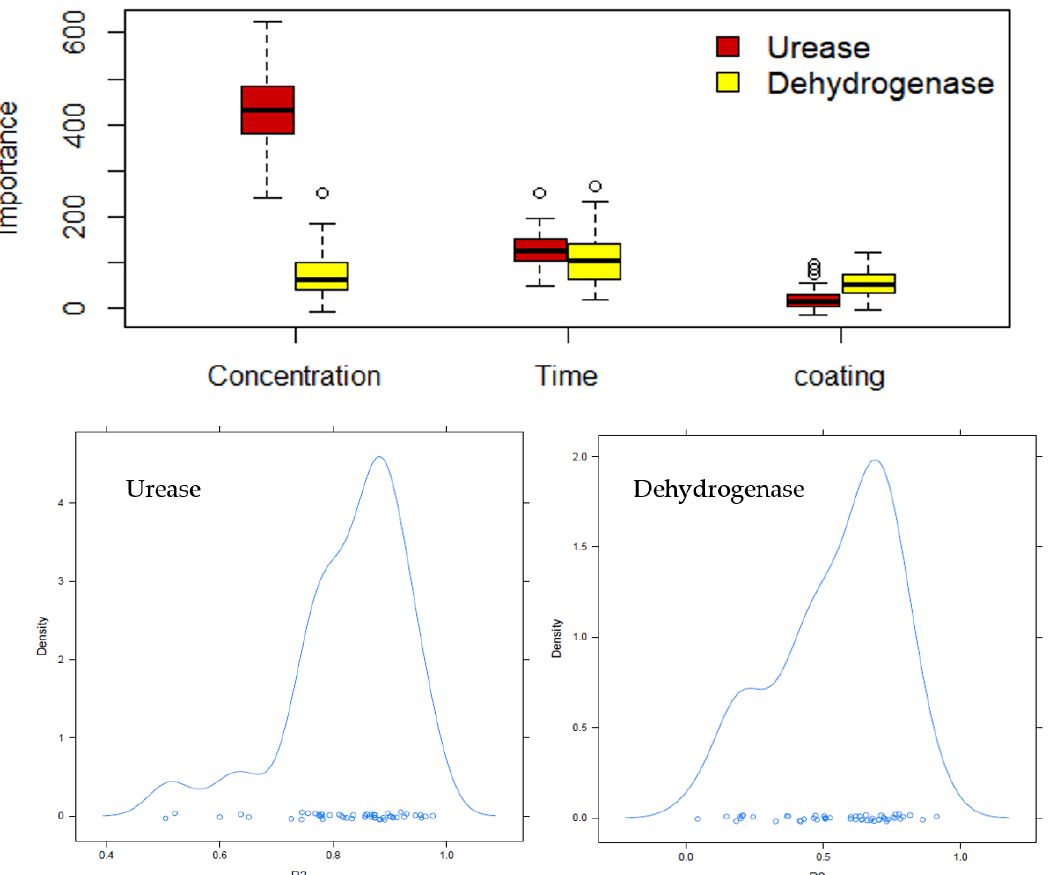
Figure 4. Random forest model and Variable importance for the urease and dehydrogenase activity and density plot of the mean R-squared value of 50 model.